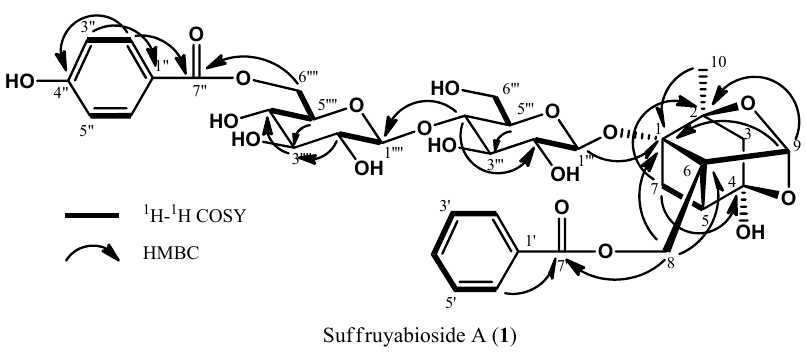
Figure 2. 2D NMR correlations of suffuruyabioside A ( 1